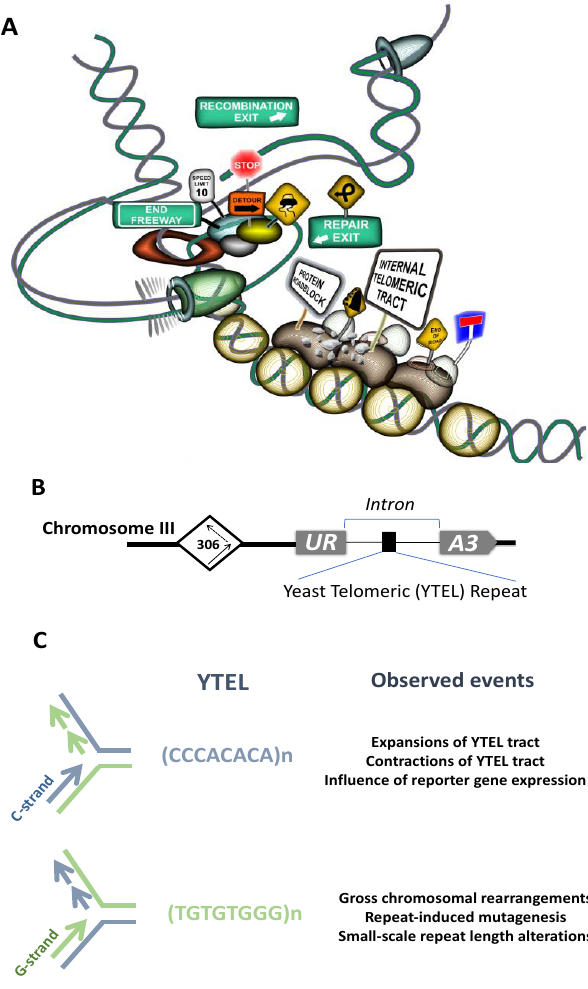
Figure 3. Mechanisms of Interstitial Telomeric Sequences (ITSs) instability (based on yeast model). ( A ) ITSs represent polar blocks for replication machinery [123,299,300]. Factors binding specifically to ITSs sequences (such as Rap1 in yeast, yellow stones on the figure, “protein roadblock” sign) influence the replication passage through this sequence depending on the orientation of the ITS tract. Additional factors interacting with Rap1, such as Sir-complex or Rif1 and Rif2 proteins (brown and gray stones), may enhance the stalling of the replication fork and regulate the replication, transcription and repair processes at ITS. Replication stalling is facilitated by the replication fork pausing complex component (Tof1-Csm3 in yeast, “stop,” “end freeway” signs) and can lead to single-stranded gap (ss-gap) formation. The stalled replication forks and ss-gaps can be repaired via HR (“recombination exit” sign) or postreplication DNA repair (“repair exit” sign). Template Switching (TS) (“detour” sign) is essential for both pathways. Replication from the other direction can result in replication fork